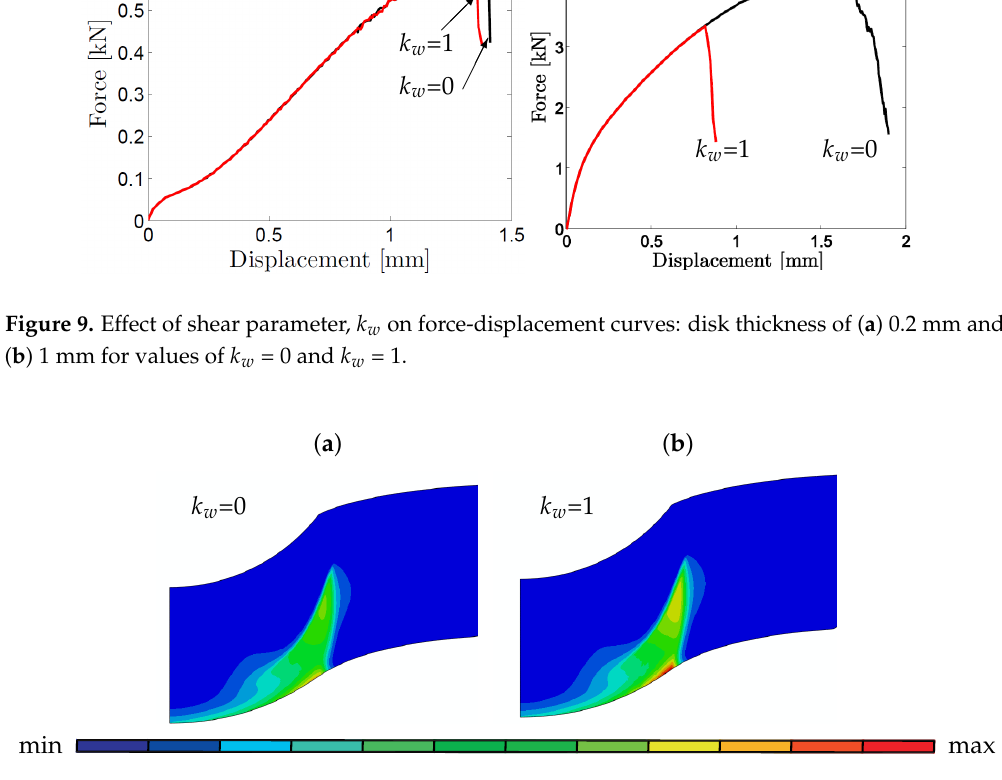
Figure 10. Damage development for a disk of 1 mm thickness at a displacement of 0.7 mm for ( a ) k w = 0 and ( b ) k w = 1: [max 2.02 × 10 − 1 ; min 6.21 × 10 − 5 ].